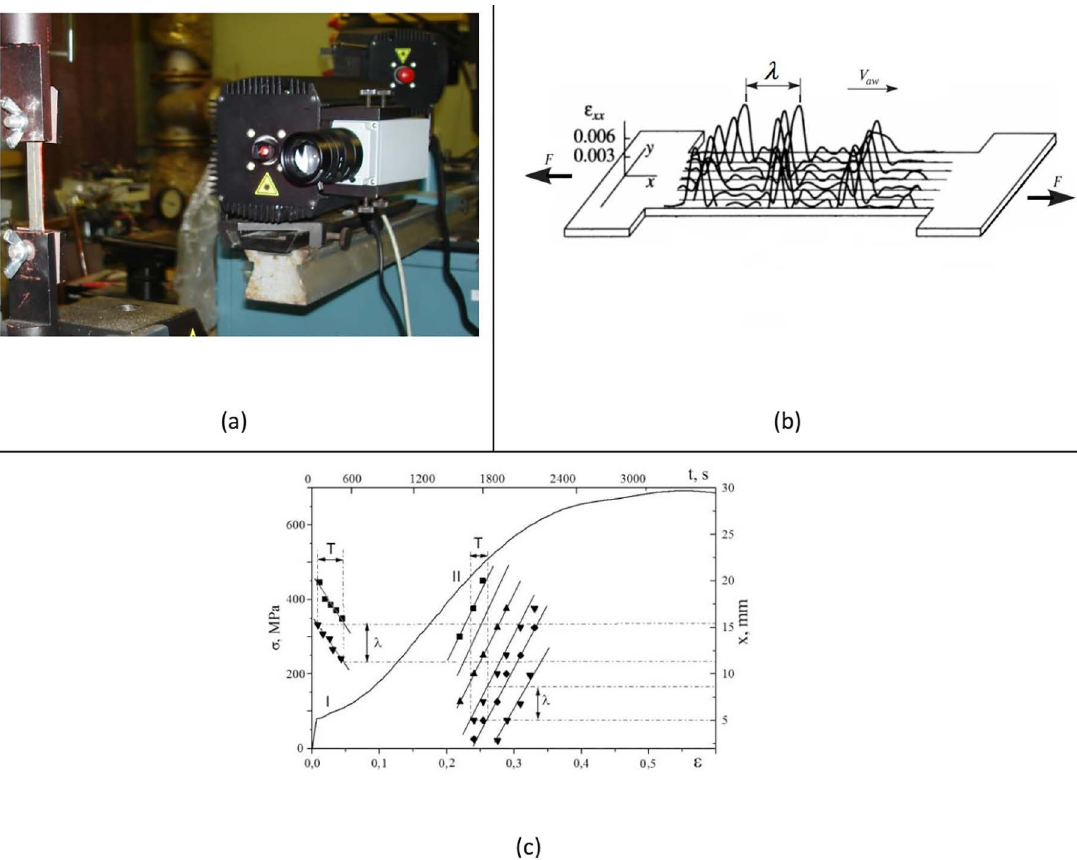
Figure 2. Localized plasticity in metals (a) - ALMEC-tv measuring system installed on an Instron-1185 testing machine; (b) - distribution of active and passive zones of strain localization; (c) - plastic flow curve and X -t